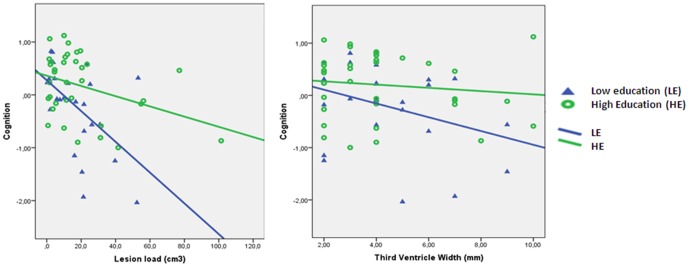
Correlation of lesion load/third ventricle width with cognition for high and low education.Correlation for low education (25th percentile: ≤11 years of education; blue triangles) r = −0.52; p<0.05/r = 0.33; p<0.05 (N = 27) vs. correlation for high education (75th percentile: ≥14 years of education) r = −0.37; p<0.05/r = 0.12; ns (N = 36), including fit of linear regression lines.